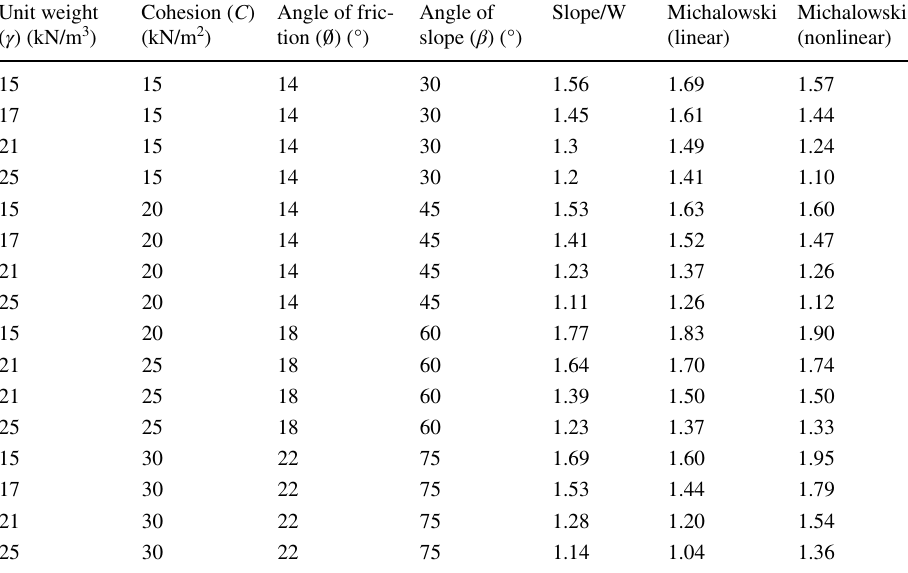
Table 4 Comparison of the present numerical method for F s with Michalowski